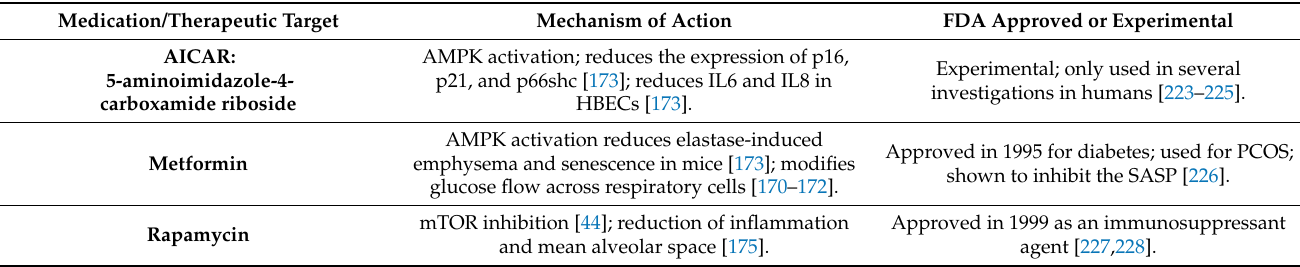
Table 2. Therapeutic options to target